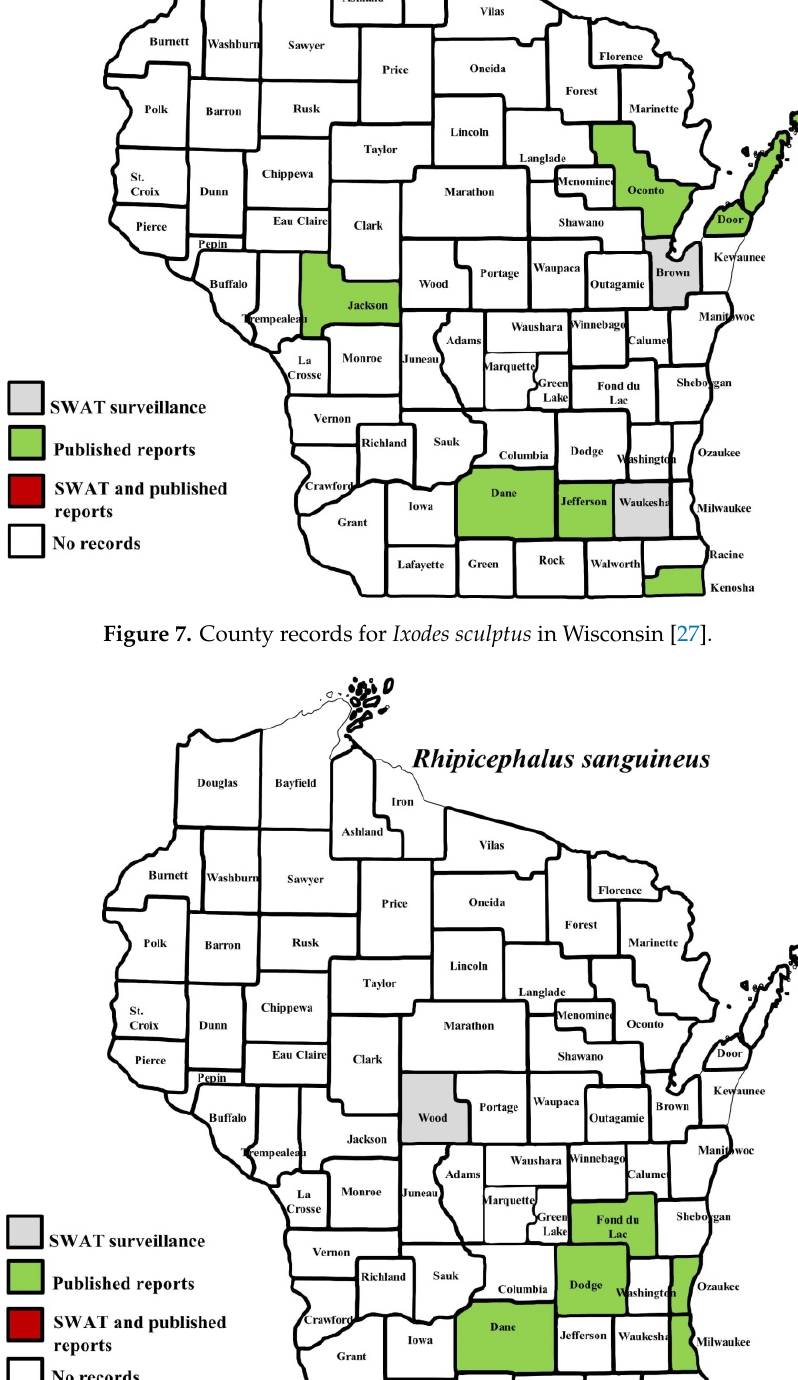
Figure 8. County records for Rhipicephalus sanguineus in Wisconsin [3,20,27].